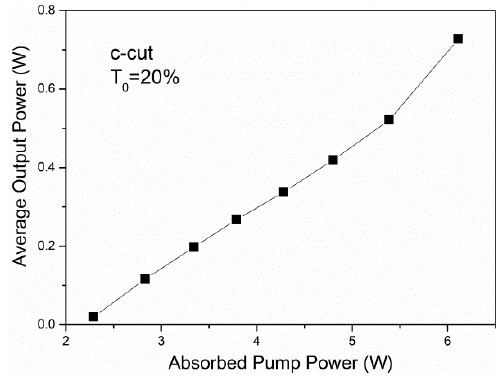
Figure 7. Passively Q-switched laser output of the Nd:ASL crystal.